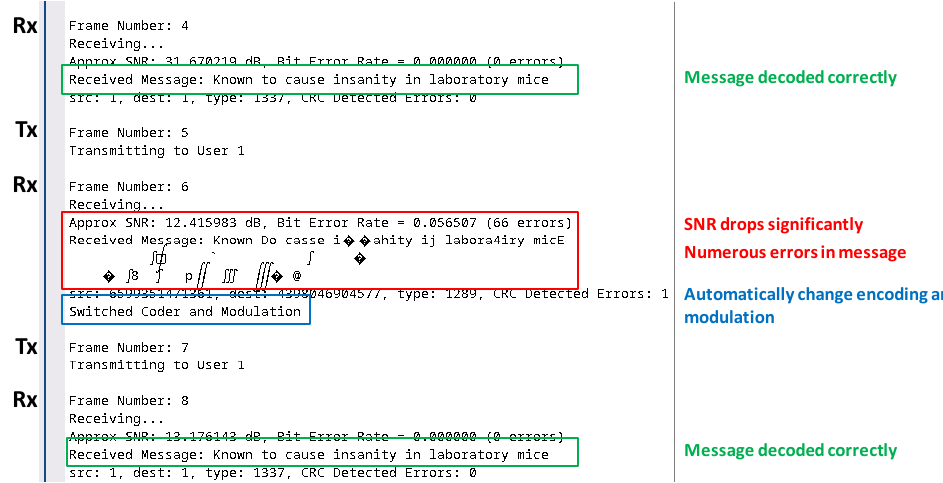
Figure 13. Console output for the ping-pong communications system when noise is artificially injected into the system. Observe the degrading SNR, causing significant errors in the received signal. The PRE then automatically adjusts the communications protocol and leverages the Object Oriented API to swap out software-defined components and change parameters for the subsequent transmission, which is then decoded without error. This demonstration, like the others, is performed over-the-air in our indoor laboratory environment, so this demonstration includes a real channel and real noise